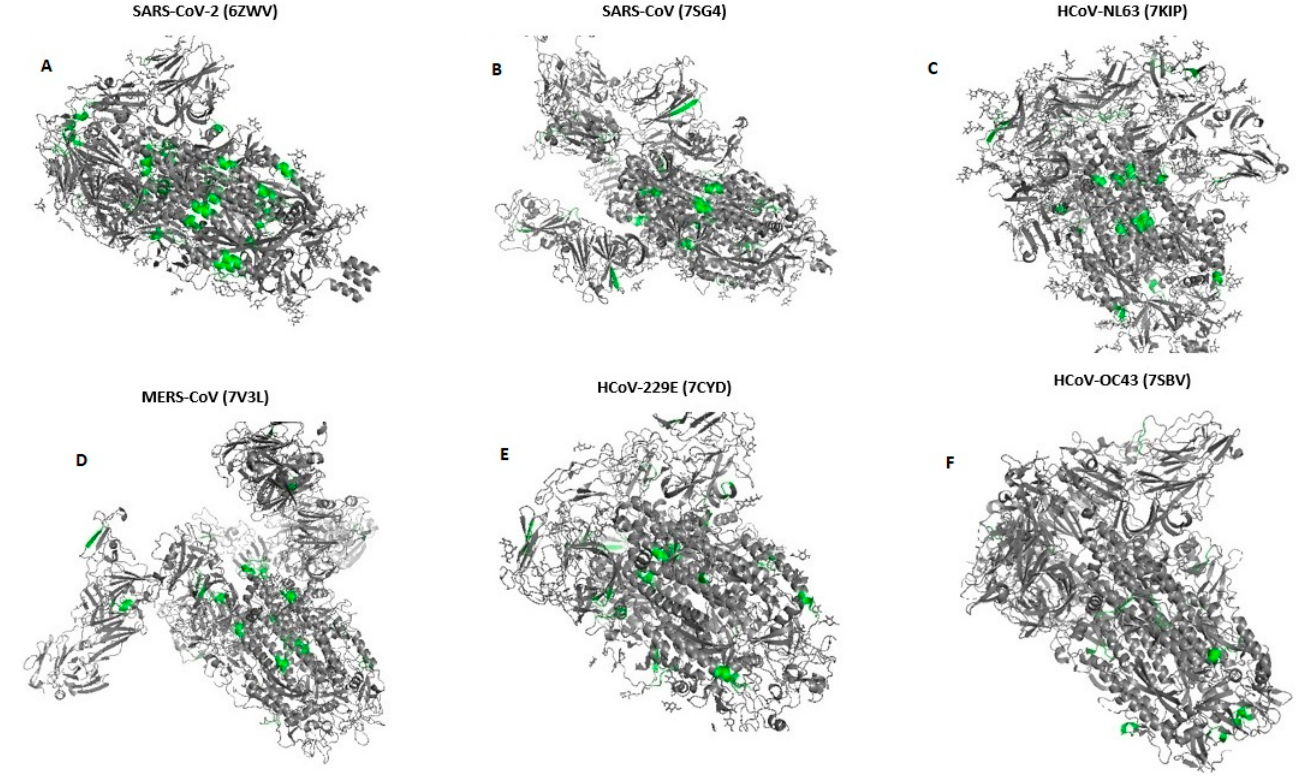
Figure 1. Location of pentapeptides shared with human endocrine autoantigens in 3-D structure spike glycoproteins of all Human Coronaviruses ( A – F ). (According to databases: PDB [27] and Al- phaFold [28]). Pentapeptides are shown with grass-green.